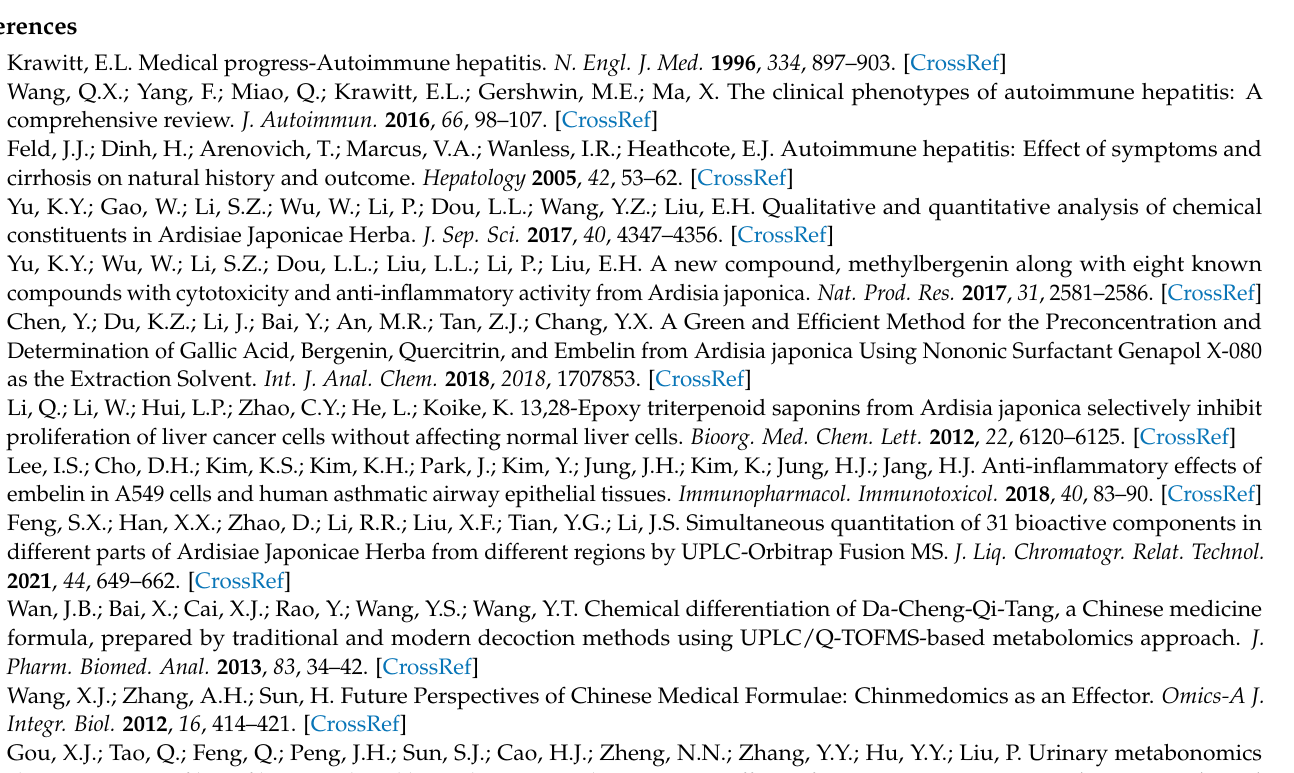
ple; Figure S2: Distribution of test statistic; Figure S3: Analysis of vitamin B6 metabolic pathway; Figure S4: Analysis of TCA circulating metabolic